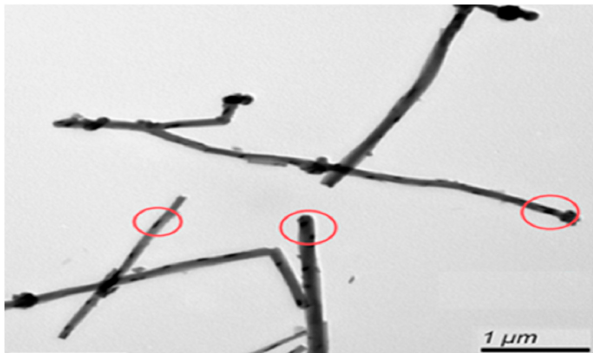
Figure 7. TEM image of iron phthalocyanine on the surface of carbon nanotubes.